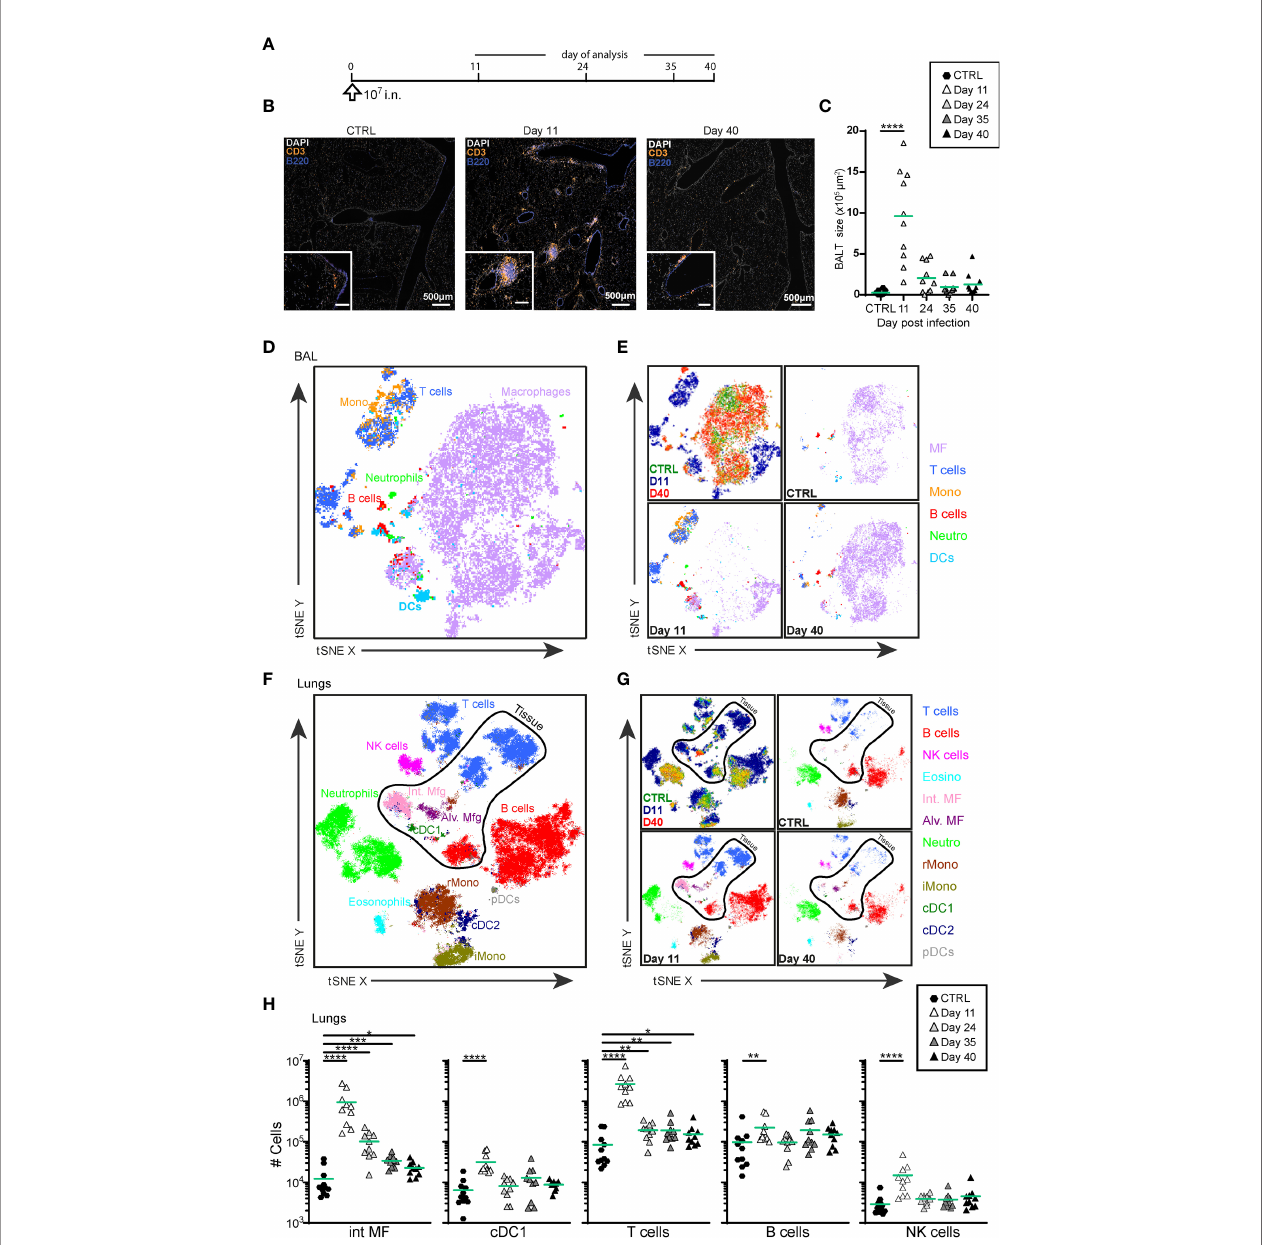
FIGURE 1 | Intranasal priming with MVA-SARS-2-S induces BALT and transient recruitment of T cells and macrophages in the lung. (A) Immunization protocol scheme. (B) Representative photomicrographs of lung sections reveal induction of BALT peaking at d11 after vaccine application. (C) Quanti fi cation of cumulative BALT size per lung section averaged on 3-4 lung sections per mouse. (D – G) Cellular composition of broncho-alveolar lavage (BAL; (D, E) and lung (F, G) analyzed by spectral fl ow cytometry and depicted as tSNE plot. Cluster identities were revealed by manual gating as shown in Supplementary Figures 1A, B ; antibodies used are listed in Supplementary Table S1 (panel 1). Cells inside the area delineated by the black line were negative for anti-CD45-FITC antibodies i.v injected 3 -5 min before mice were sacri fi ced and are thus considered to be from the lung parenchyma. Cells outside that area were CD45-FITC + and considered to be within or in close vicinity to blood vessels. (D, F) Representative tSNE plot of concatenated samples from one mouse each sacri fi ced before (control) or 11 or 40 days after vaccine application; colors refer to indicated cell populations; antibodies used are listed in Supplementary Table S1 (panel 2). (E, G) Upper left, concatenated data as in (D, F) , colors indicate different mice analyzed. Upper right and bottom plots: de-concatenated data, colors indicate cell populations. (H) Absolute cell numbers of interstitial macrophages (int MF), type 1 conventional dendritic cells (cDC1), NK, T and B cells in lung. (C, H) Pooled data from 3-4 experiments with n = 10 per group. (C, H) Individual values (symbols) and mean group value (lines). Statistical analysis was done on log-transformed values using ordinary or Welch ’ s ANOVA followed by Dunnett ’ s T3 multiple comparisons test. *p < 0.05, **p < 0.01, ***p < 0.001, ****p <